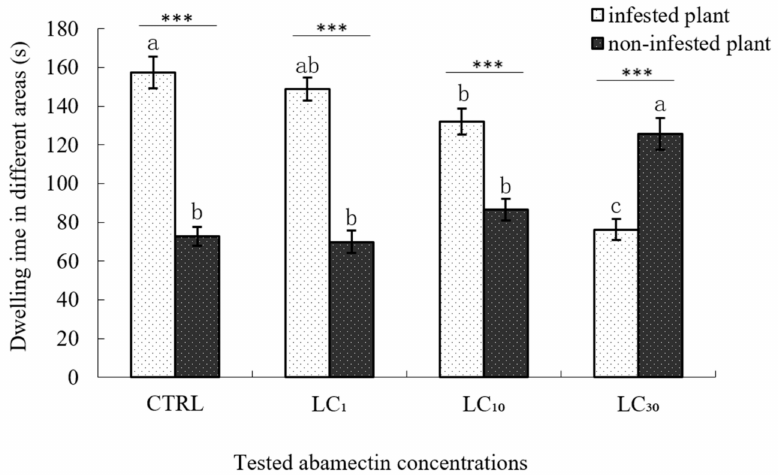
Figure 1. Dwelling time of Encarsia formosa in different plant areas treated with abamectin. Note: *** p < 0.001 (significantly different between the two groups, t -test). The same letter over the bars of infested plant or non-infested plant areas indicates no significant differences between the various concentrations (Duncan’s multiple range test, α < 0.05). The “infested plant area” means cotton plants in the four-armed olfactometer infested with 3rd or 4th instar B. tabaci nymphs, while the “non-infested plants” means healthy cotton plants without whitefly infestation in the four-armed